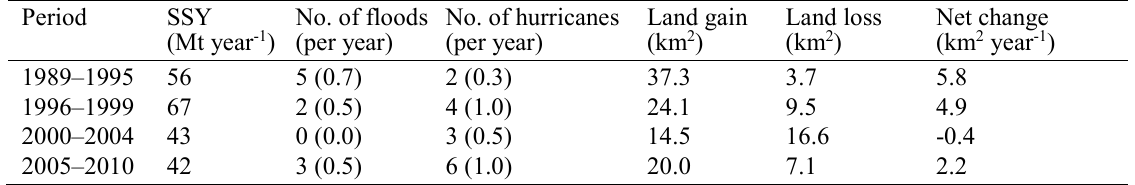
Table 1 Land gain and loss in the Atchafalaya Deltaic Complex in relation with annual suspended sediment yield (SSY) and the number of major floods and hurricanes (Data sources from Rosen & Xu, 2013).